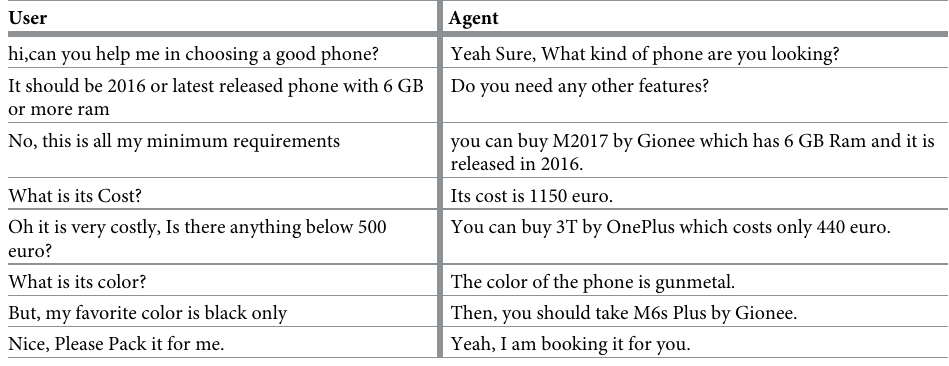
Table 3. Sample dialogue conversation